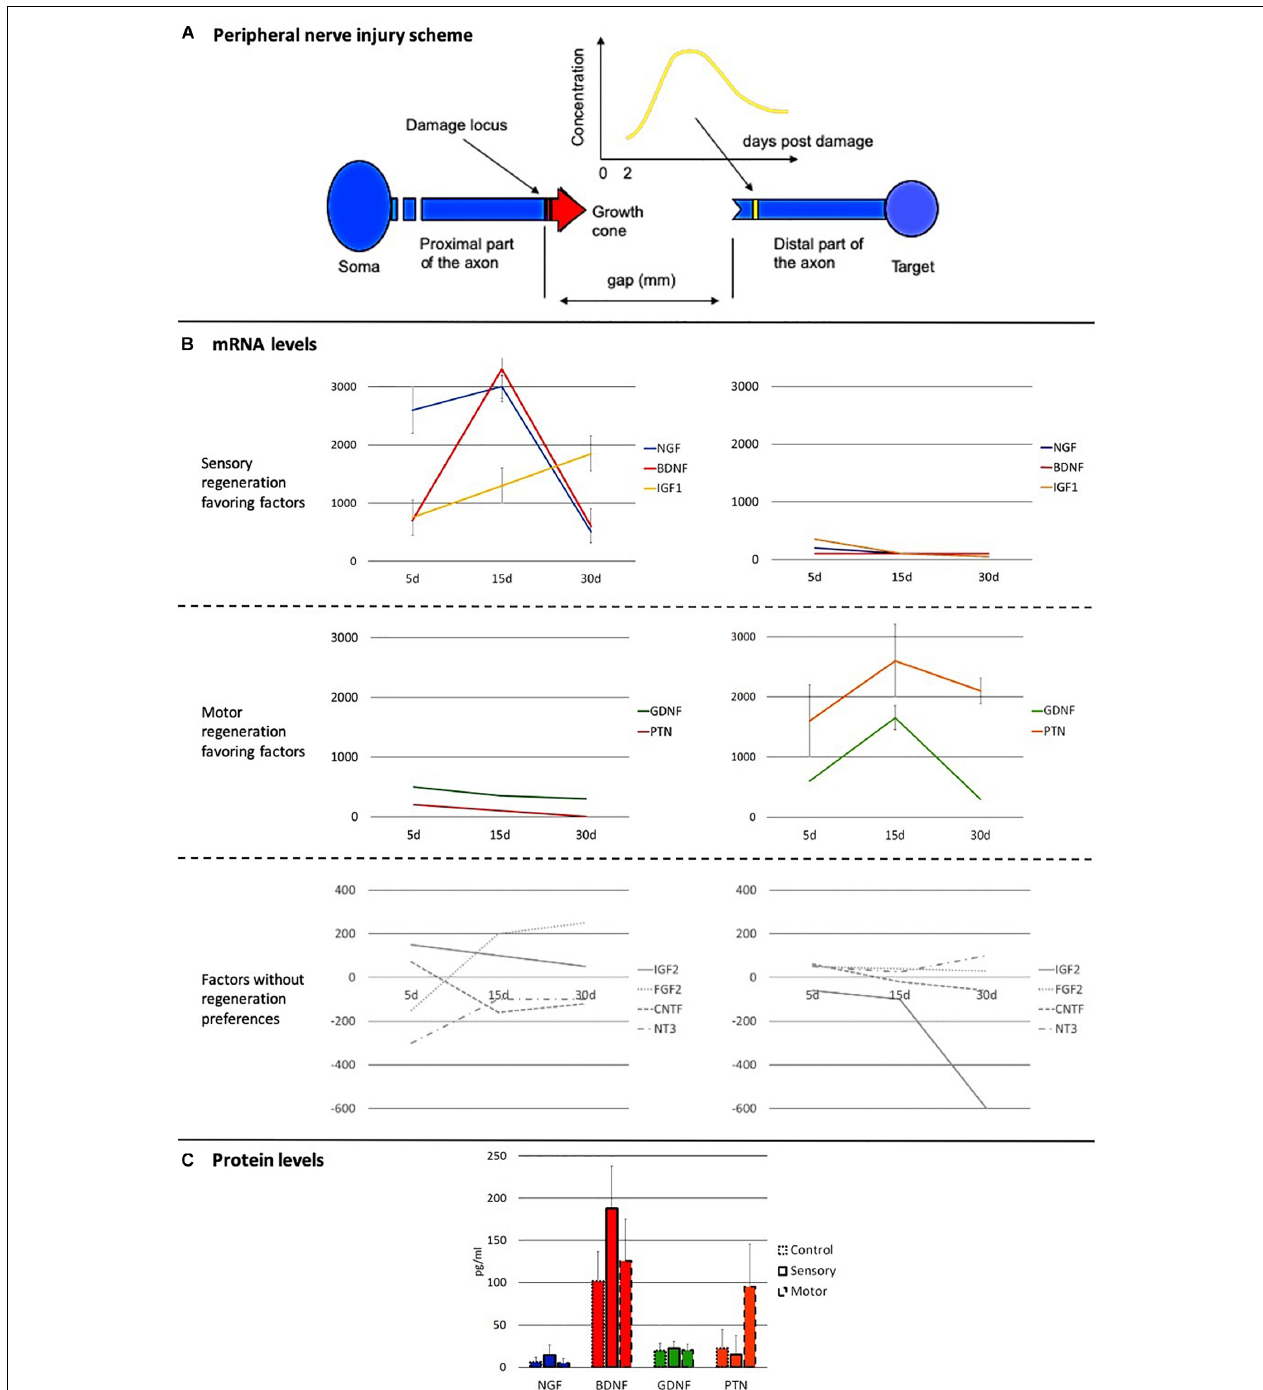
FIGURE 7 | Dynamic behavior of the principal axon growth-promoting factors in the injured peripheral nerve. (A) Scheme of the peripheral nerve, of the damage region and of the growing process of the regenerating axons. A time-dependent expression profile of an axonal growth promoter molecule during the regeneration of the peripheral nerve at the site of the damage is also depicted. (B) mRNA expression profiles of the principal axonal growth promoter molecules in the distal stump, close to the injury locus. Left column: Expression profiles in injured sensory nerves. Right column: Expression profiles in injured motor nerves. Profiles are grouped according to their preferences in facilitating the regeneration of type of nerve: biomolecules mainly favoring the regeneration of sensory fibers (first row), biomolecules mainly favoring the regeneration of motor fibers (second row), and molecules not showing any preference for a specific type of fiber (third row). Data are represented in % change and in a logarithmic scale. (C) Protein levels (pg/mL) of the most important neurotrophic factors for the regeneration of both sensory and motor axons. Values are shown for uninjured nerves and for injured nerves 15 days after the injury [After (Höke et al., 2006)].